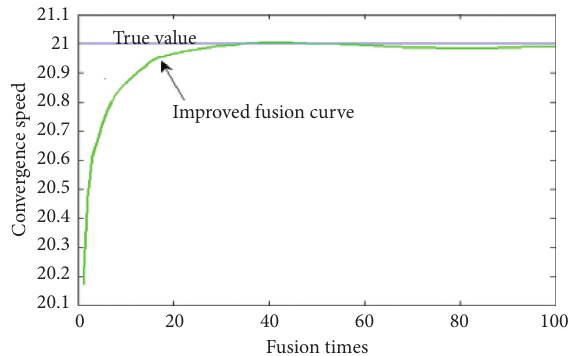
Figure 10: Fusion output curve of the improved